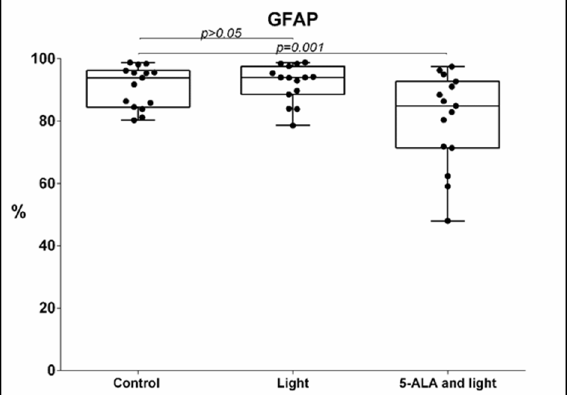
Figure 3. Boxplot showing the change in the percentage of GFAP-positive GB-MSCs across paired samples of control cell cultures, cell cultures treated with light only, and cell cultures exposed to 5-ALA and light. The GFAP expression was evaluated using multi-color flow cytometry, and every dot on the box plot represents the percentage values of all GFAP-positive GBM-MSCs in that particular cell culture.